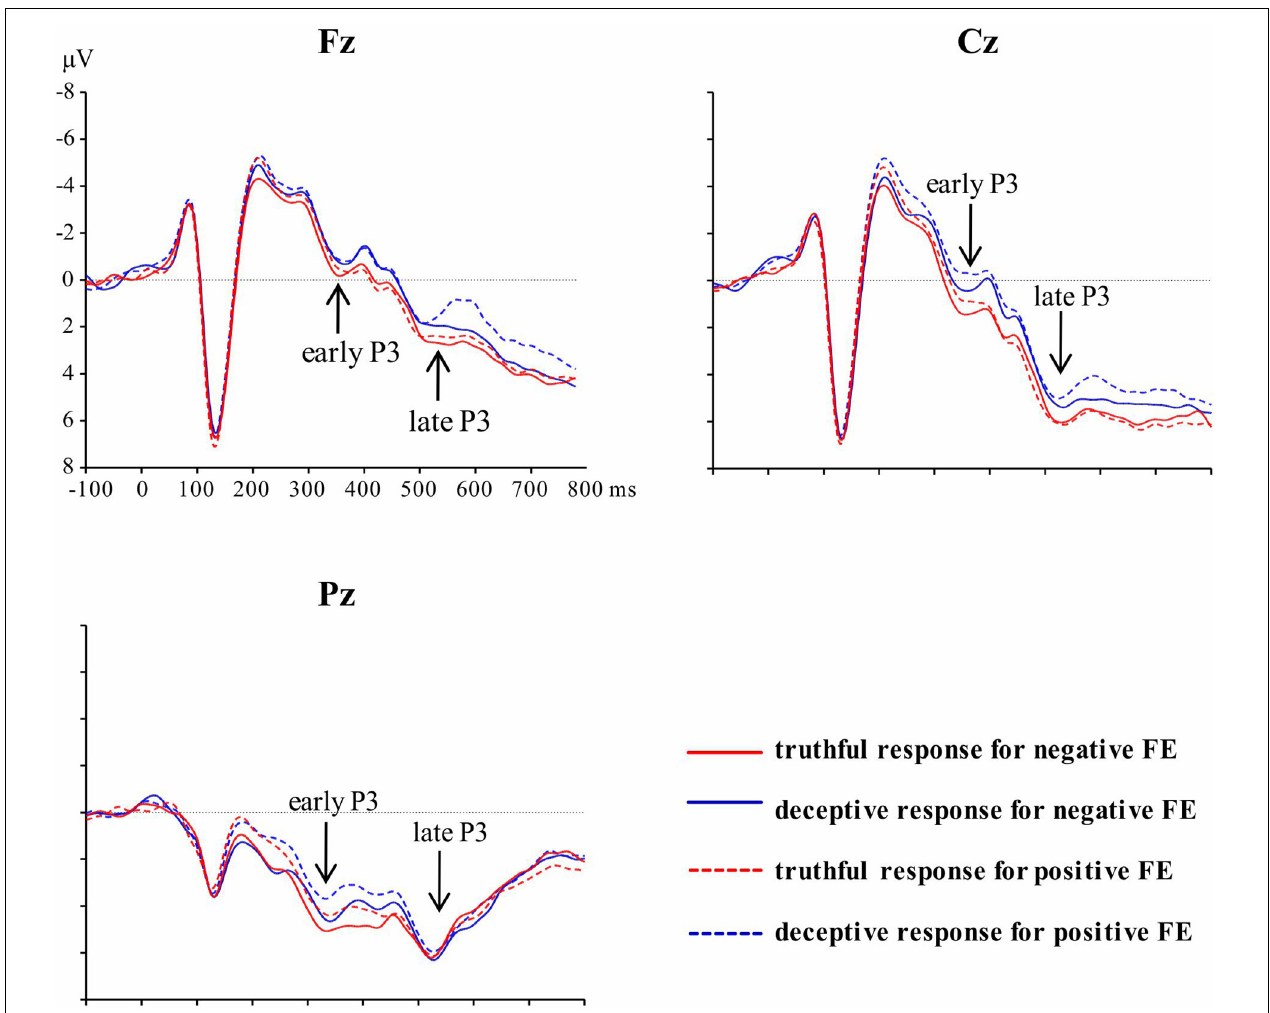
FIGURE 3 | Grand average waveforms at Fz, Cz, and Pz for each of the four experiment conditions.